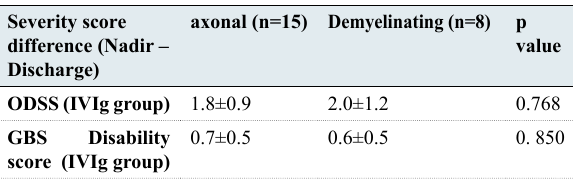
Table 6: Clinical Severity according to ODSS and GBS